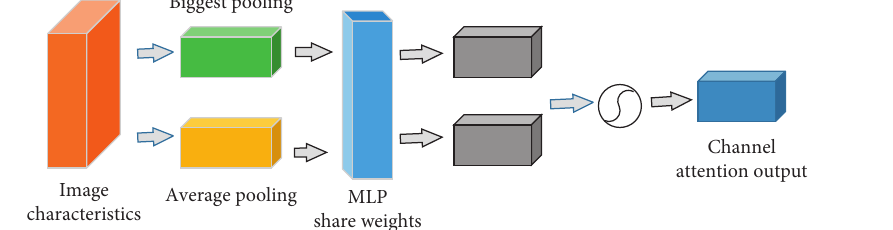
Figure 2: The channel attention structure.